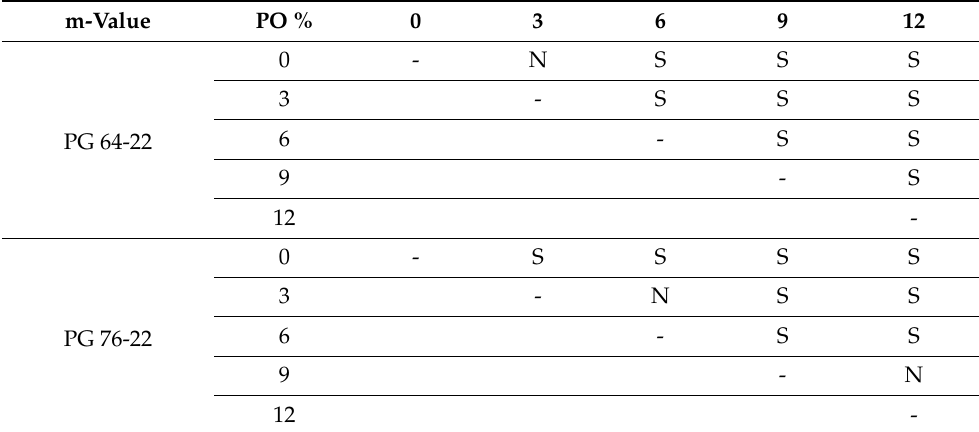
Table 11. Statistical analysis results of the m-value as a function of processed oil content − 24 ◦ C ( α =